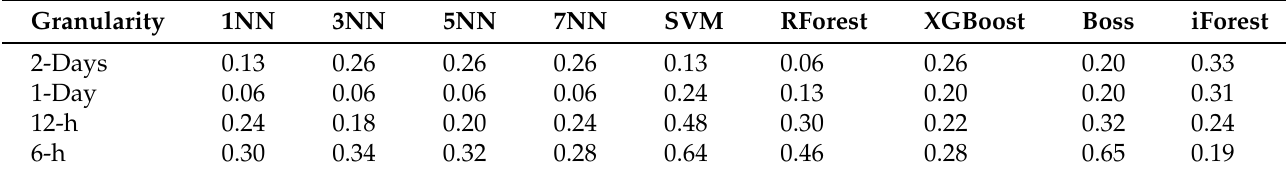
Table 7. Sensitivity metric of our proposed algorithms at different